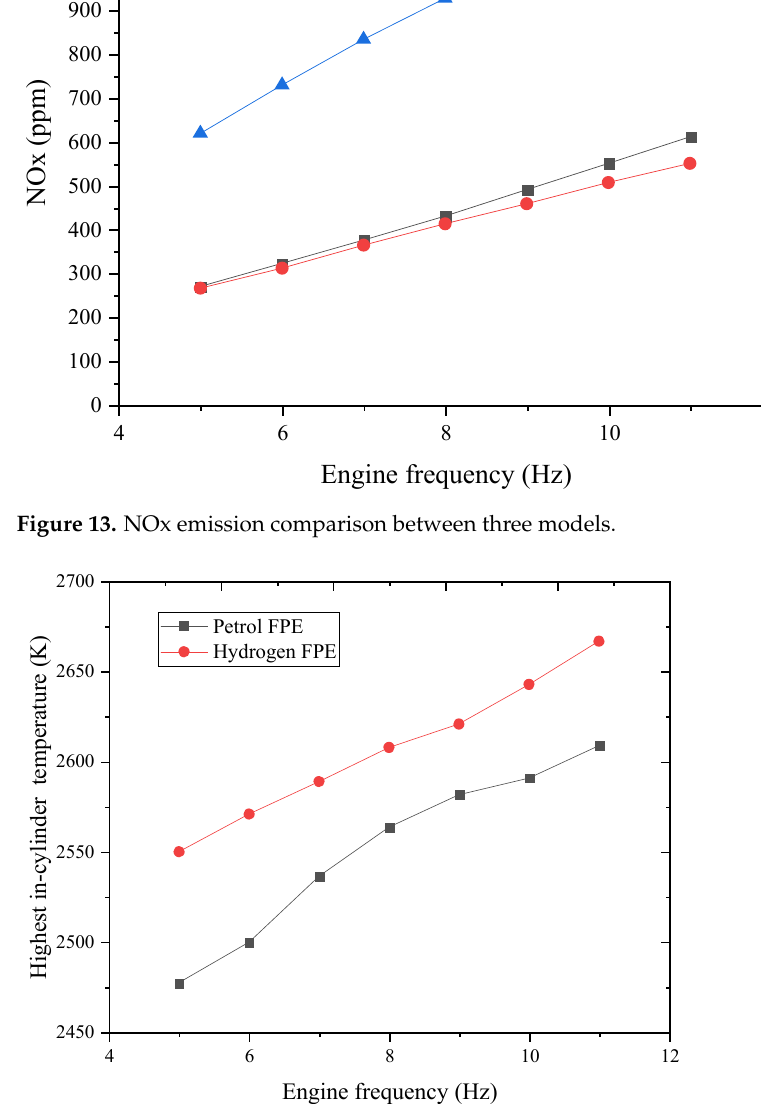
Figure 14. Highest in-cylinder temperature of gasoline FPE and hydrogen FPE.